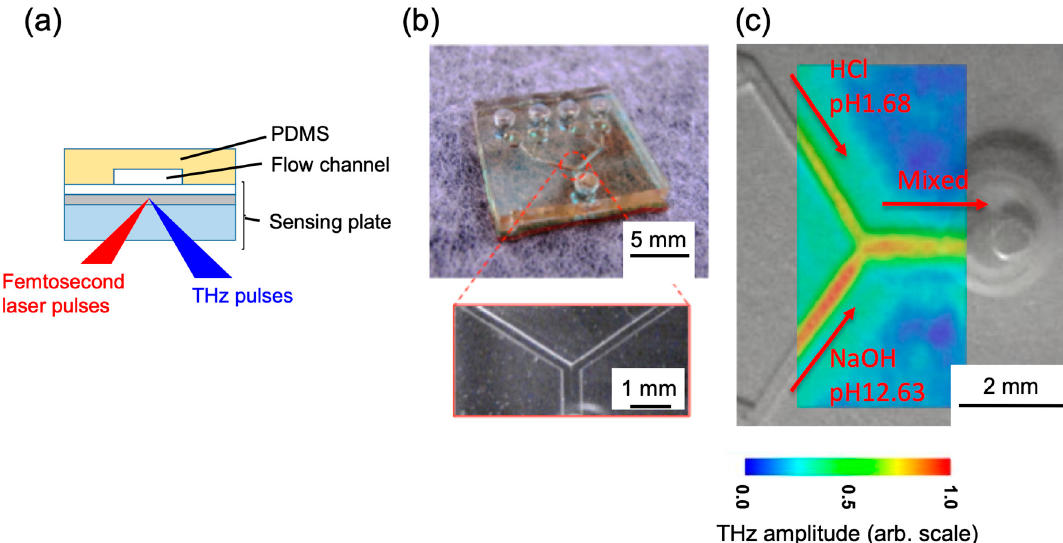
Figure 6. ( a ) Cross-sectional schematic and ( b ) photograph of the microflow channel on the sensing plate. ( c ) Microflow channel in ( b ) superimposed with the distribution of THz radiation from the sensing plate. The color scale is normalized by the maximum amplitude in the image.